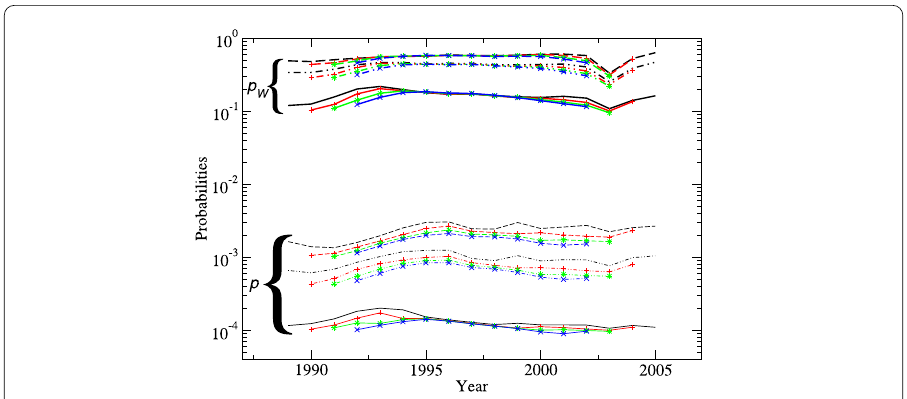
Figure 2 The densities ℘ ( t , (cid:2) t ) and ℘ W ( t , (cid:2) t ) with the following color and symbol code: black without symbols represents (cid:2) t = 2, red with + represents (cid:2) t = 3, green with ∗ represents (cid:2) t = 4, blue with × represents (cid:2) t = 5; (—) lines represent W = 1, (– · · –) lines represent W = 2, (– – –) lines represent W = 3; thin lines represent ℘ ( t , (cid:2) t ), and thick lines represent ℘ W ( t , (cid:2) t ). The brackets signal the location of ℘ ( t , (cid:2) t ) and ℘ W ( t , (cid:2) t ) in the plot